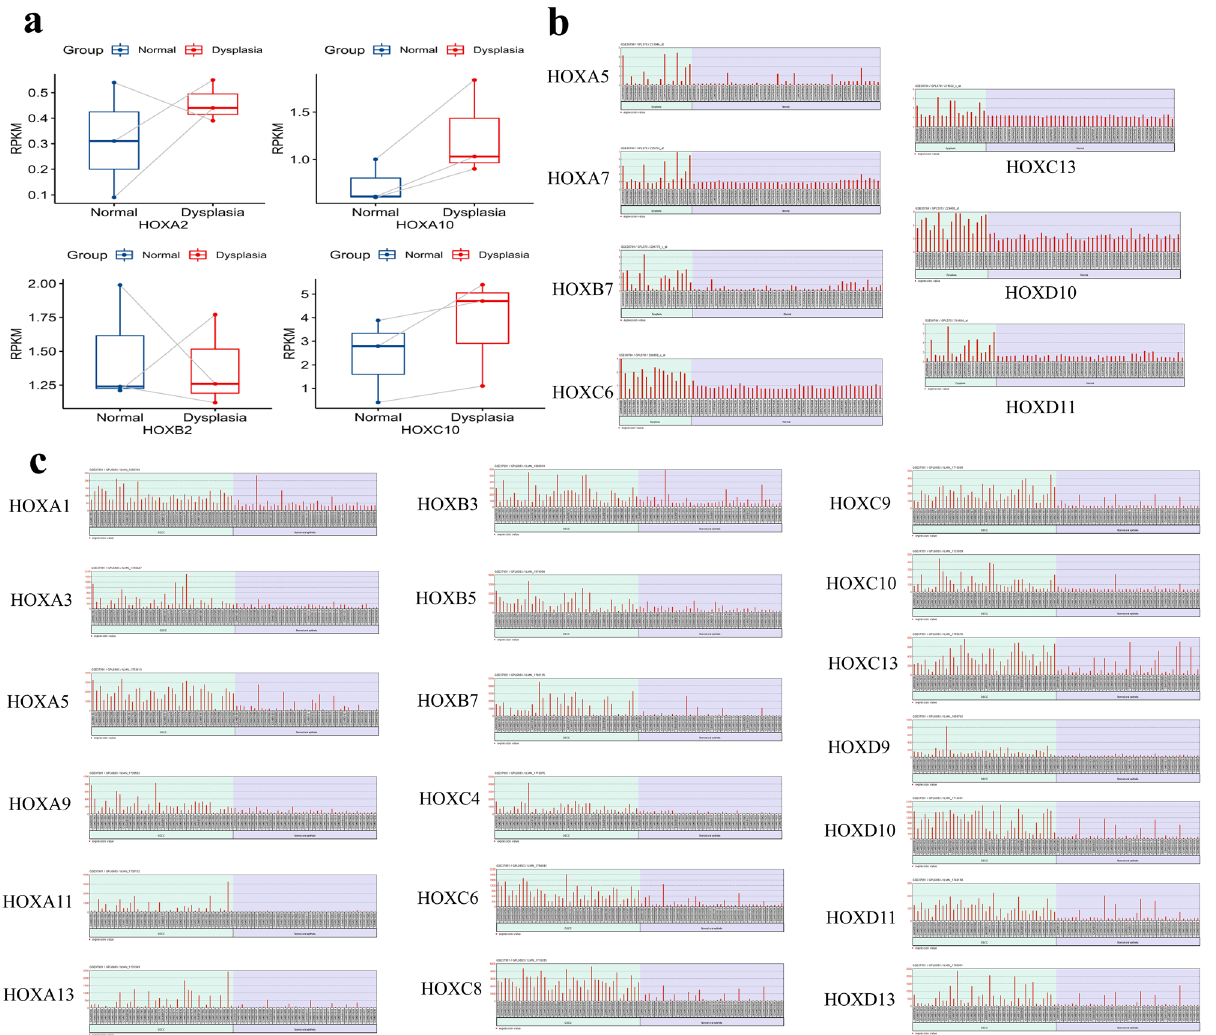
Figure 3. ( a – c ): HOX genes showed deregulated expression pattern in oral dysplasia compared to the normal. ( a ) HOXA2 , HOXA10 and HOXC10 expression showed an increasing trend whereas HOXB2 showed a decreased trend of expression during the early onset of dysplasia (n = 3 paired samples). The connected lines represent the paired data points analyzed for each sample. ( b ) HOXA5 , HOXA7 , HOXB7 , HOXC6, HOXC13 , HOXD10 and HOXD11 were shown to be significantly upregulated ( p < 0.01) in the GSE30784 dataset in a panel of 17 dysplasia and 45 oral mucosa tissues. ( c ) HOXA1, HOXA3, HOXA5, HOXA9, HOXA11,